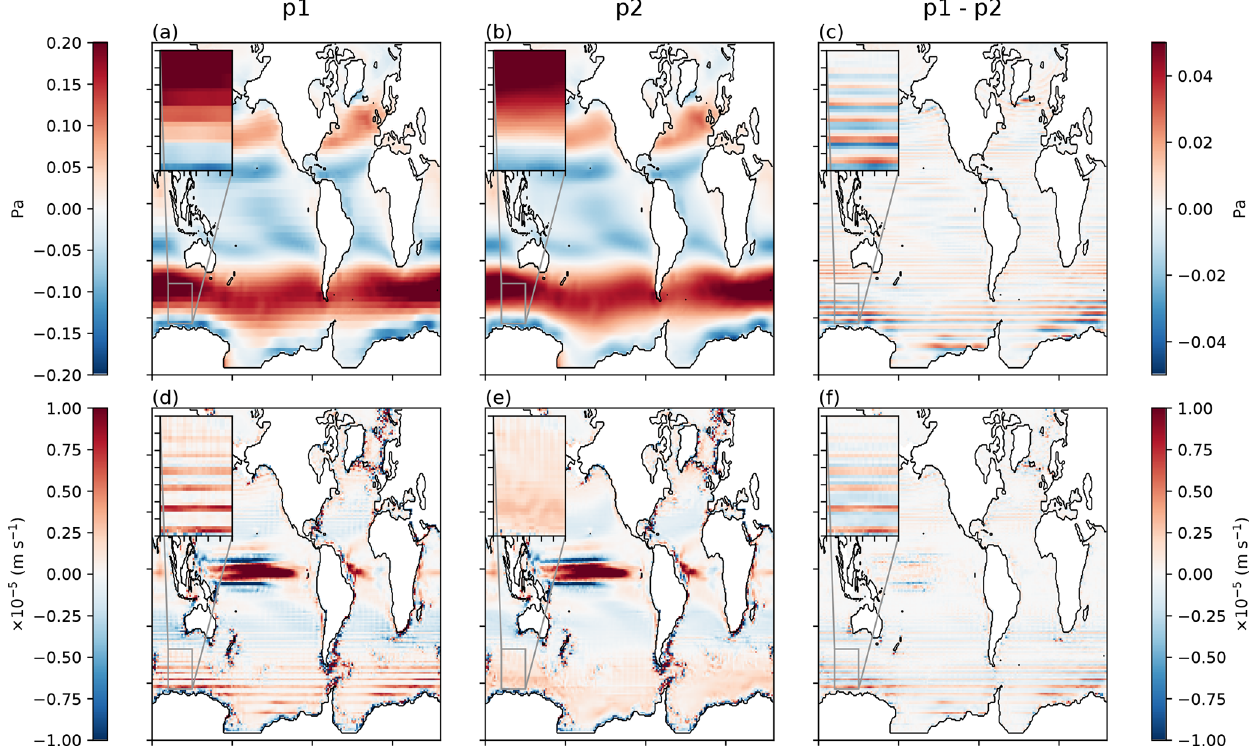
Figure E2. Climatologies of surface ocean zonal wind stress (a, b) and vertical velocity near 100m depth (d, e) computed over 200 years of the piControl simulation of the p1 (a, d) and p2 (b, e) model variants, and the differences between p1 and p2 (c, f) . Results are shown on the native NEMO grid. The insets show an enlargement of the Southern Ocean south of